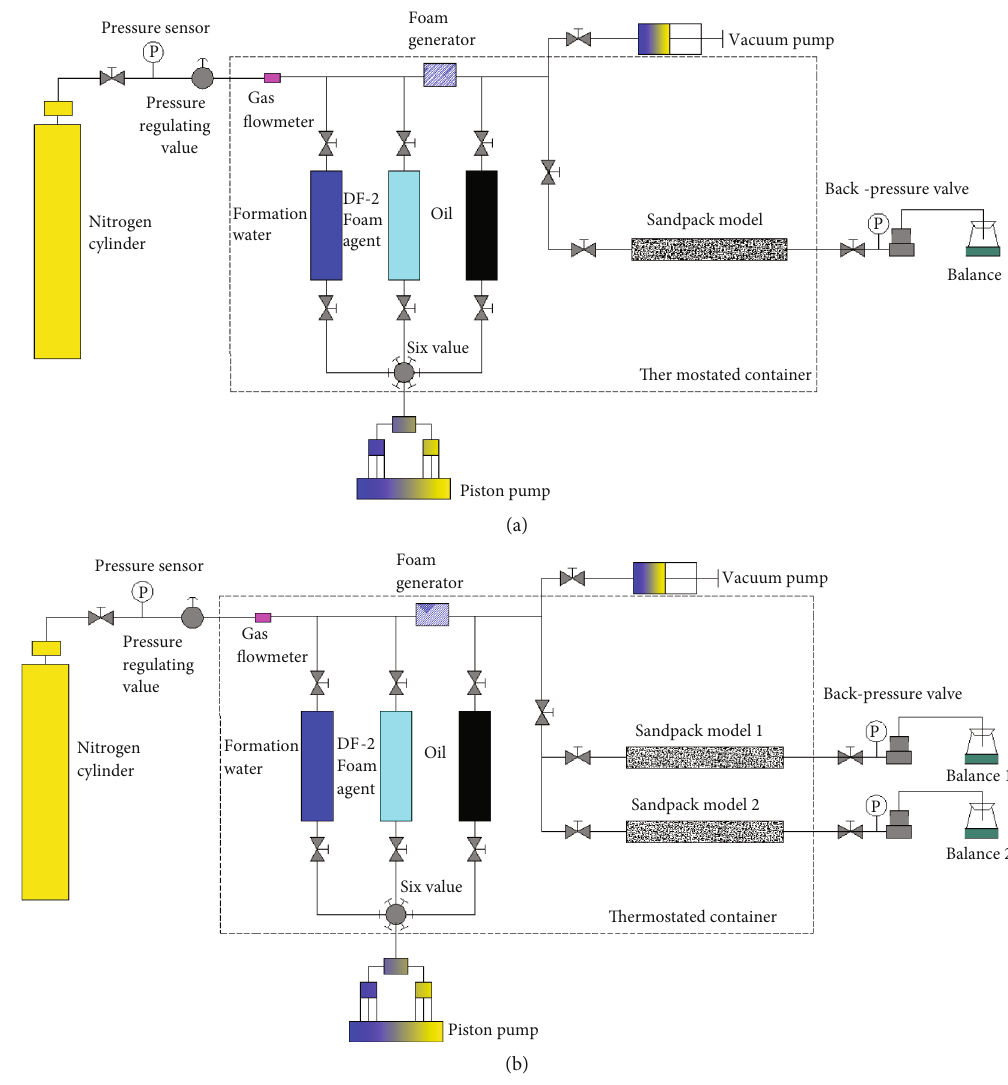
Figure 4: Flow charts of single-sandpack and dual-sandpack